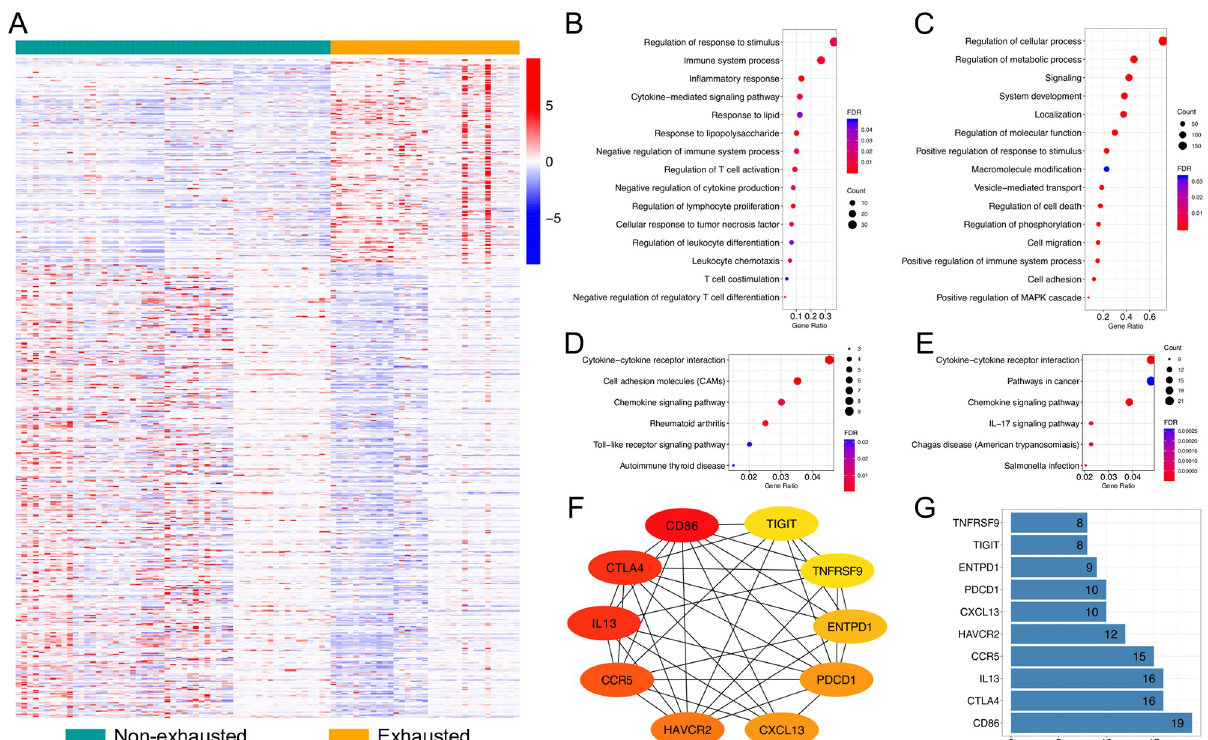
Fig 2. Human differentially expressed gene (DEG) analysis. (A) Heatmap constructed using 199 upregulated and 441 downregulated genes in exhausted T-cells. Significant changes are determined as fold change > 1.5 and False discovery rate (FDR) < 0.05. (B–C) Gene ontology (GO) and (D– E) Kyoto encyclopedia of genes and genomes (KEGG) pathway enrichment analysis for human DEGs. Selected key biological processes in (B) upregulated and (C) downregulated genes. GO analysis is performed based on biological process. (D) All six enriched KEGG pathways in upregulated genes. (E) The top six enriched KEGG pathways in downregulated genes. GO terms and KEGG pathway remain when the FDR is < 0.05. (F–G) Functional protein association networks of upregulated genes. (F) Cytoscape software and Cytohubba plugin have been used to identify hub genes with top 10 interaction degrees via analyzing interactions files obtained from the Search Tool for the Retrieval of Interacting Genes/Proteins (STRING) database. Red to yellow represents interaction degrees from top to bottom. (G) Interaction degrees of the hub genes. X-axis represents the number of adjacent